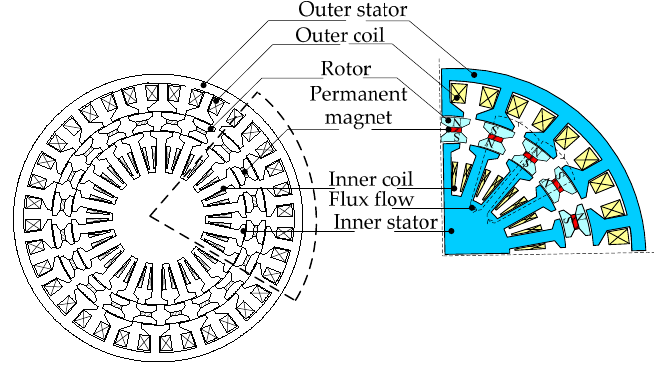
Figure 1. Basic structure of three-phase DSSR-PMG. Table 1. DSSR-PMG parameters.